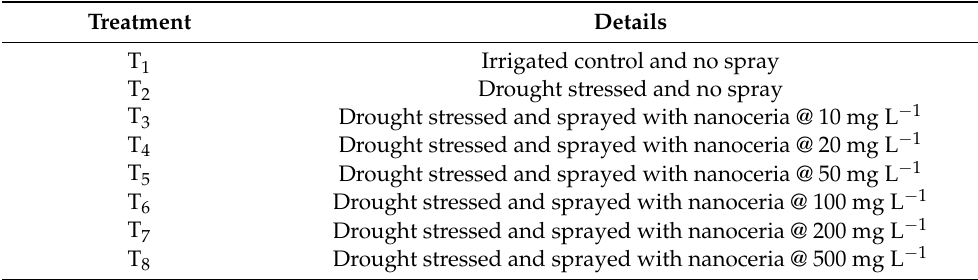
Table 1. Pot culture experiment treatment details.